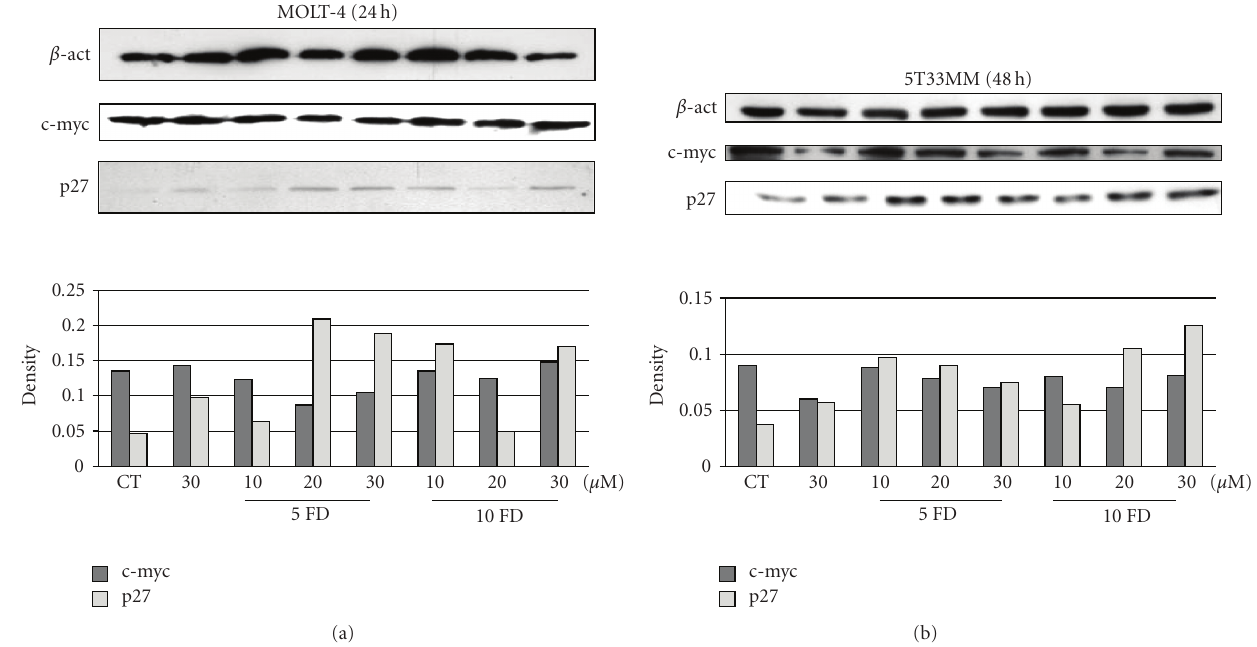
Figure 5: Expression of cell cycle molecules. The e ff ects of di ff erent concentrations of forodesine and dGuo on the expression of p27 and c-myc are shown in MOLT-4 (a) and 5T33MM (b) cells. β -actin was used as loading control, one experiment representing 3 is